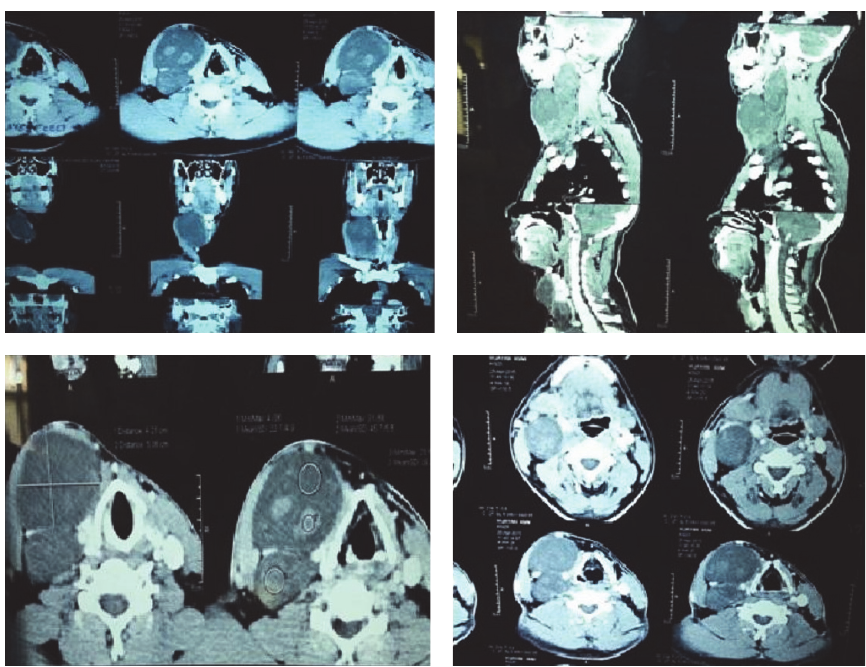
Figure 3: CECT images showing the lesion in the neck, extending to submandibular area and mediastinum.